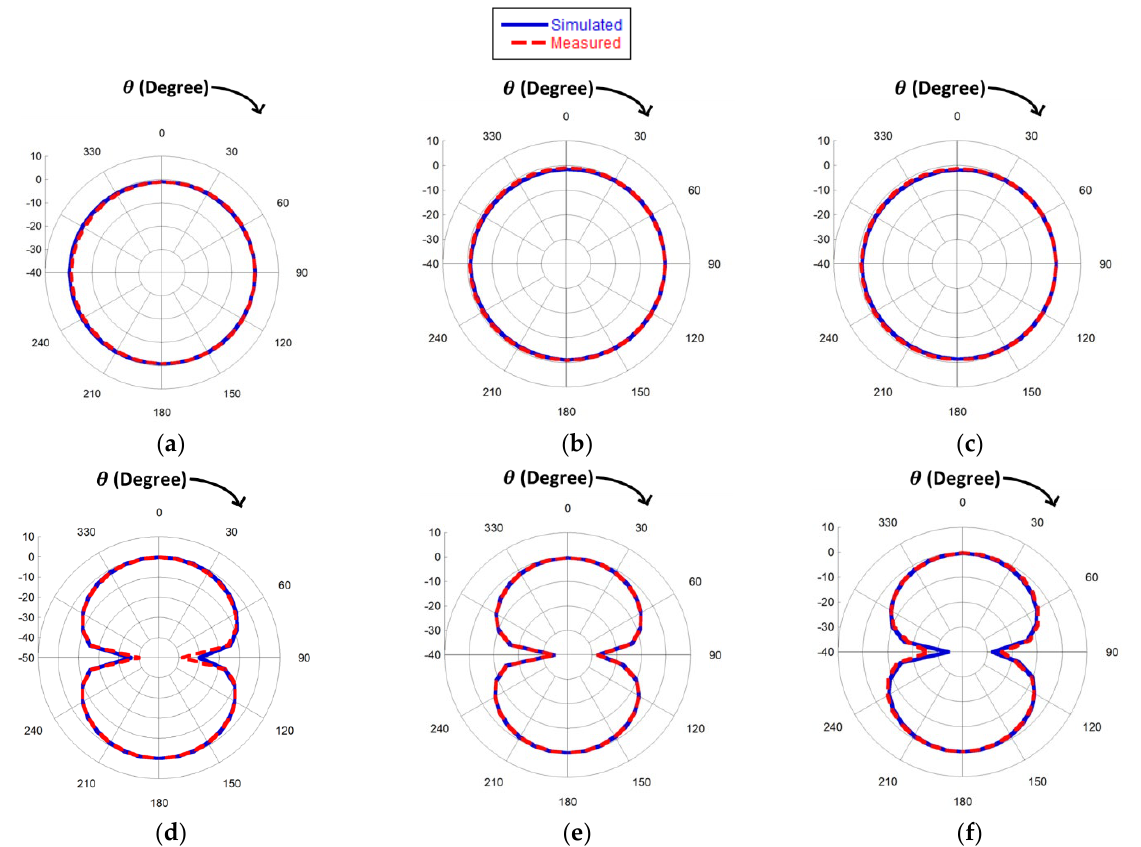
Figure 10. Normalized simulated and measured radiation pattern of XZ ( a – c ) and YZ plane ( d – f ) of the proposed antenna for respective frequencies 840 MHz, 900 MHz, and 950 MHz.